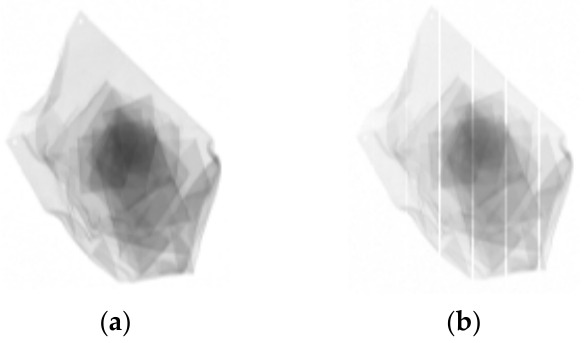
Figure 8. ( a ) Shading of low-energy image; ( b ) shading of high-energy image.